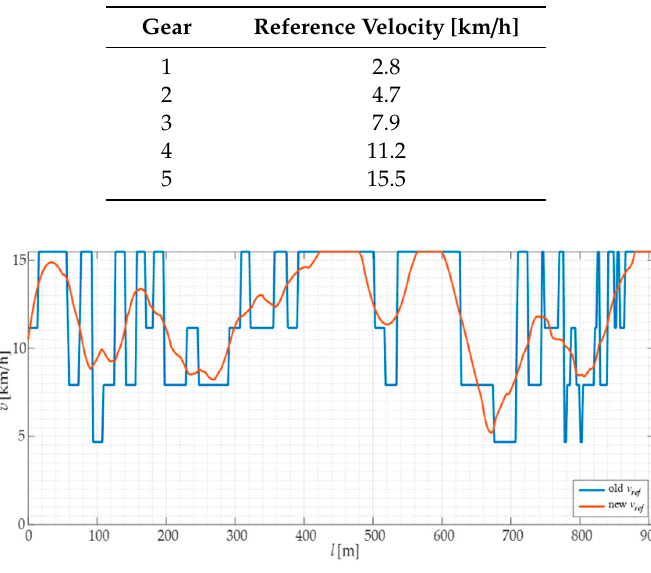
Figure 11. Reference velocity before and after filtering with a Savitzky–Golay filter.